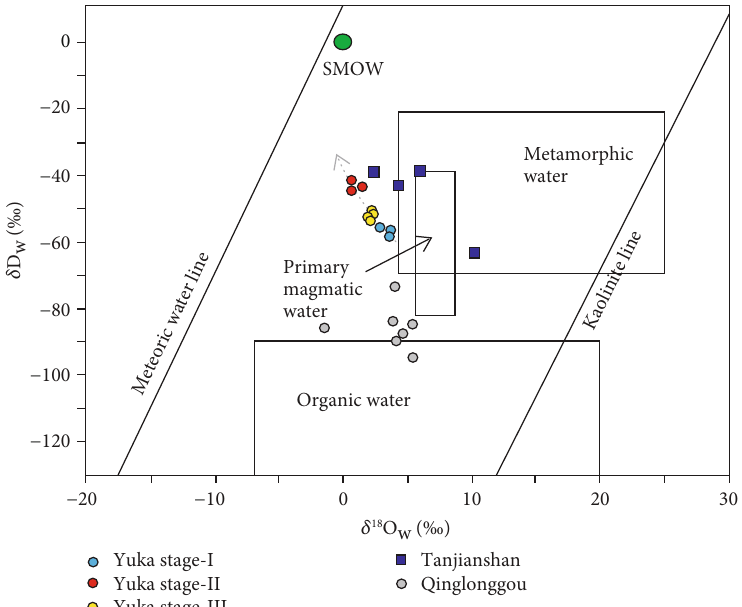
Figure 8: δ 18 O – δ D plots of the ore fl uids of the Yuka gold deposit. Primary magmatic and metamorphic water boxes and meteoric water line are from Taylor [72]. Organic water fi eld is quoted from Sheppard [73]. The data from Tanjianshan and Qinglonggou deposits are quoted from Zhang [74]. Table 3: The δ 34 S values of ores and rocks in the Yuka gold deposit. Sample